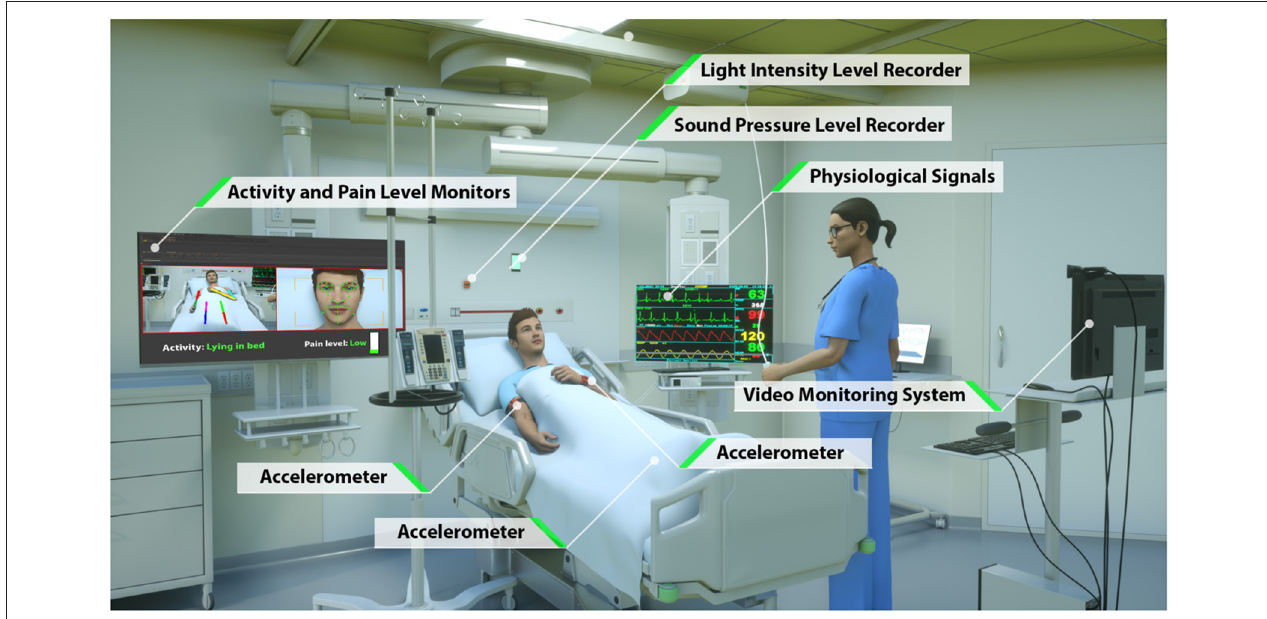
FIGURE 1 | Intelligent ICU room introduced by Davoudi et al. (26). In this study, we augment traditional vital signs from electronic health records with novel activity data from wrist-worn accelerometer sensors.